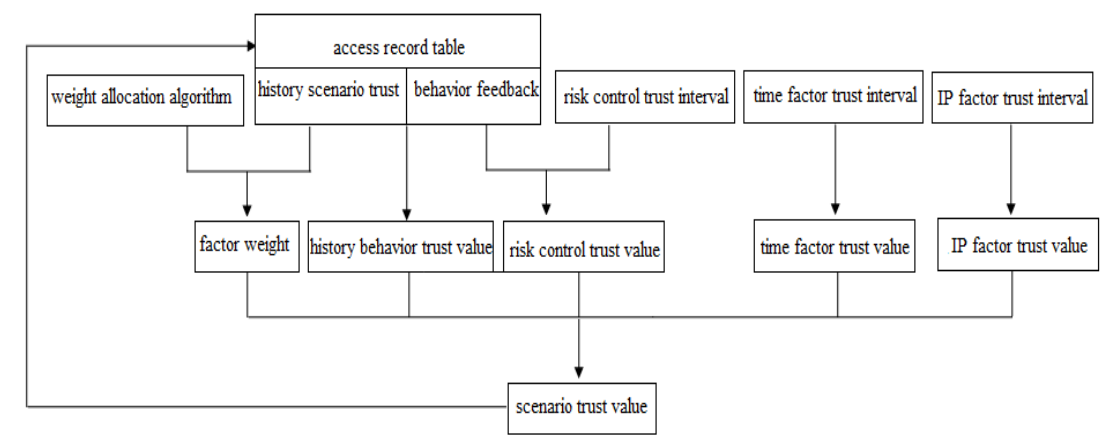
Fig. 1. Data flow